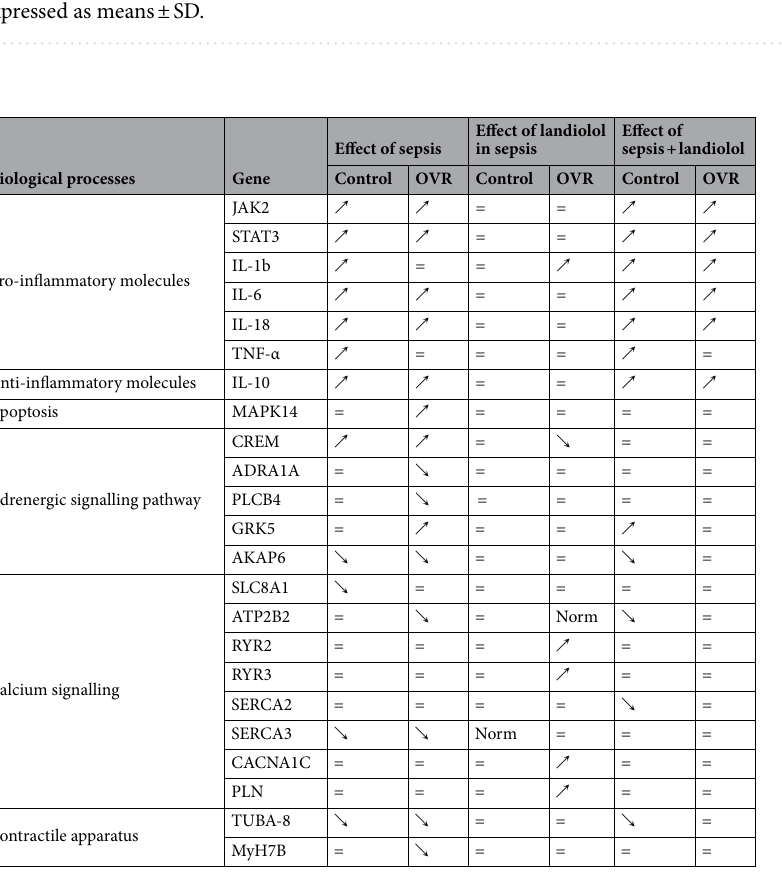
Table 2. Biological parameters 18 h after CLP. Evans Blue Evans Blue tissue concentration in pulmonary right cranial lobe, Lactate lactate plasma concentrations, Procalcitonin procalcitonin plasma concentration. Data are expressed as means ± SD.